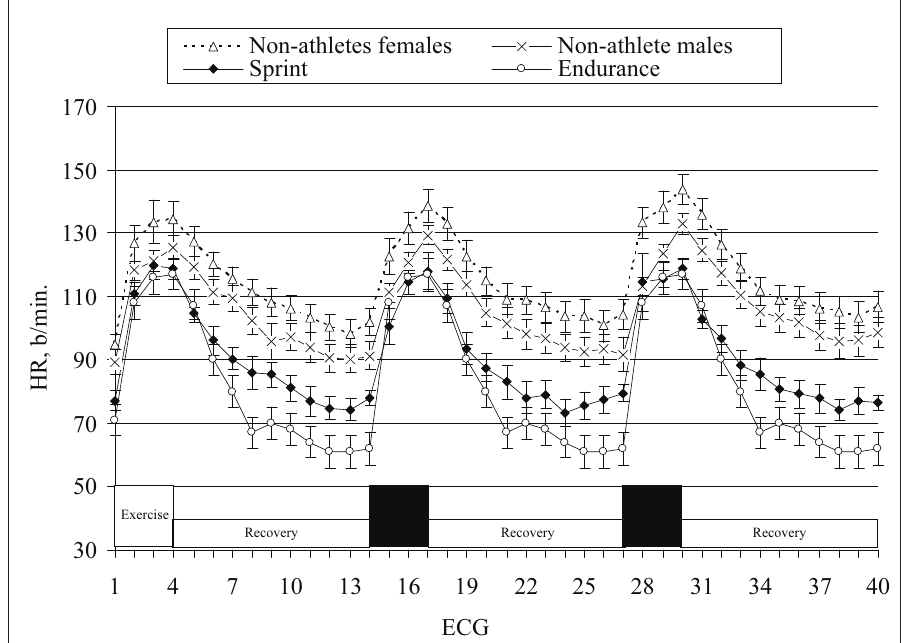
Figure 1. Dynamics of HR in four experimental cohorts while performing 3 dosed exercise tests with 2 minutes of recovery between them